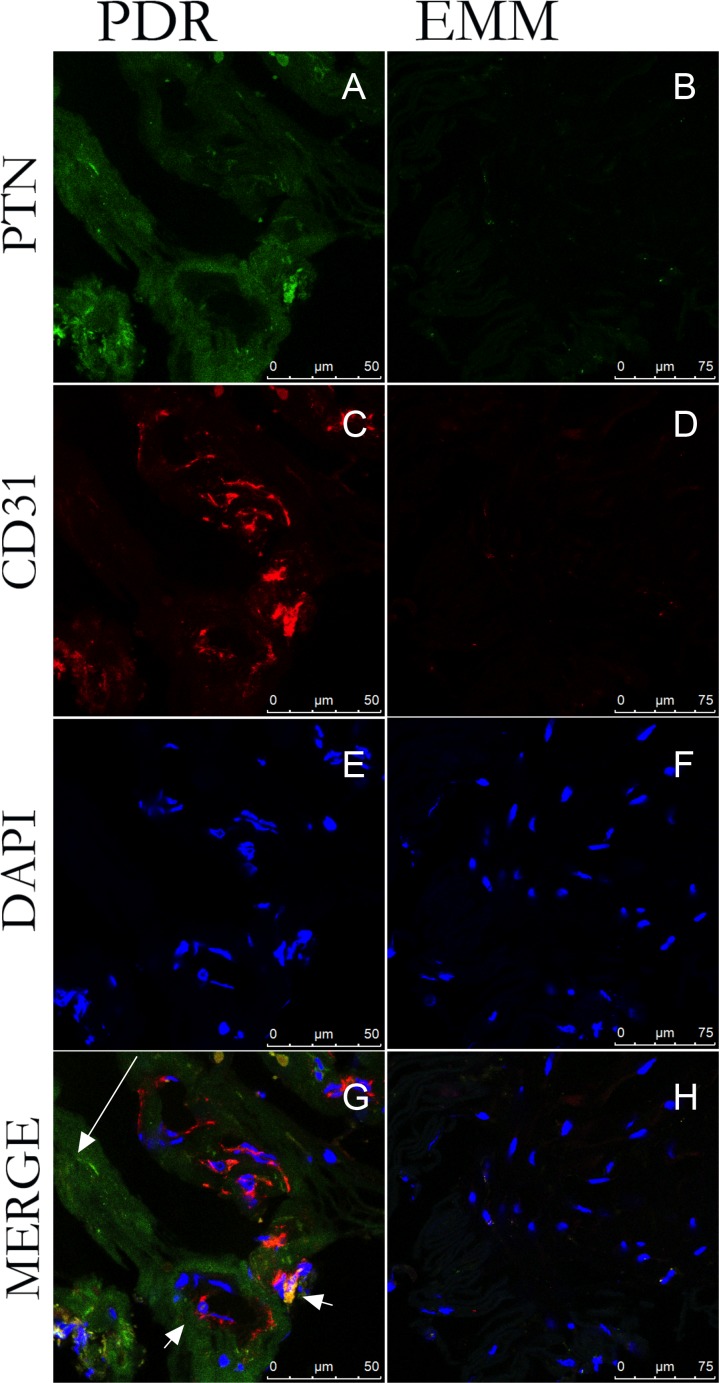
Detection of PTN on epiretinal membranes from PDR patients.Micrographs show immunofluorescence double staining of epiretinal PDR membrane sections (left column) and EMM sections (right column) for PTN (A, B) and CD31 (C, D). Nuclei were stained with DAPI (E, F). Images in the fourth row are merged (G, H). Double staining revealed PDR membranes expressing PTN and CD31. PTN expression was detected in CD31-labeled cells (panel G, short arrow) and in fibrous-like tissue (panel G, long arrow). However, neither PTN nor CD31 was detected in EMMs. Bar, 50 μm.